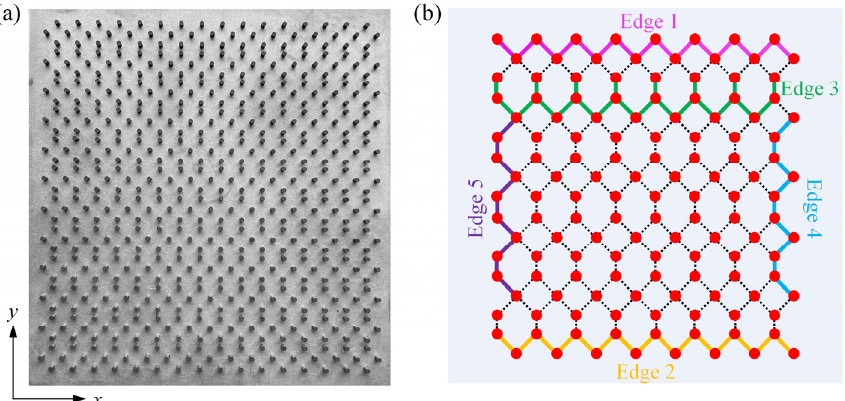
Figure 1. Square-hexagon lattice GPC. ( a ) Photo picture of experimental sample. ( b ) Five types of edges highlighted in five polylines colored in different colors. There were three zigzag-type edges (Edges 1–3) along x direction. When the outermost row of YIG cylinders of Edge 1 (outlined with a magenta polyline) is removed, Edge 2 (outlined with a yellow polyline) is formed. When the outermost row of Edge 2 continues to be removed, Edge 3 (outlined with a green polyline) is formed. Two armchair-type edges (Edges 4–5) are directly along y direction. When the outermost row of Edge 4 (outlined with blue polyline) is taken away, Edge 5 (marked with purple polyline) emerges.